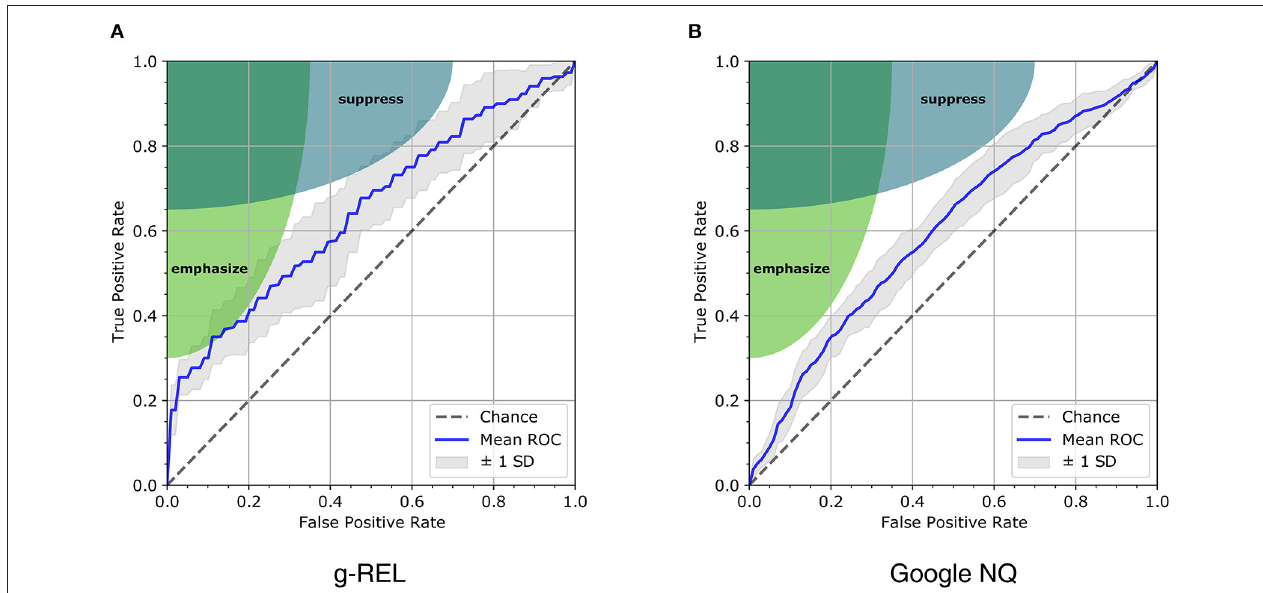
FIGURE 6 | Receiver Operator Characteristic curves for the SVC* relevance prediction models trained and tested using all samples from the g-REL data (A) and the Google NQ data (B) . The curves are averaged over the 10 training and test cycles; the gray area indicates the standard deviation ( ± 1 SD). The elliptic areas indicate acceptable true and false positive for emphasizing or suppressing contents based on Feit et al.